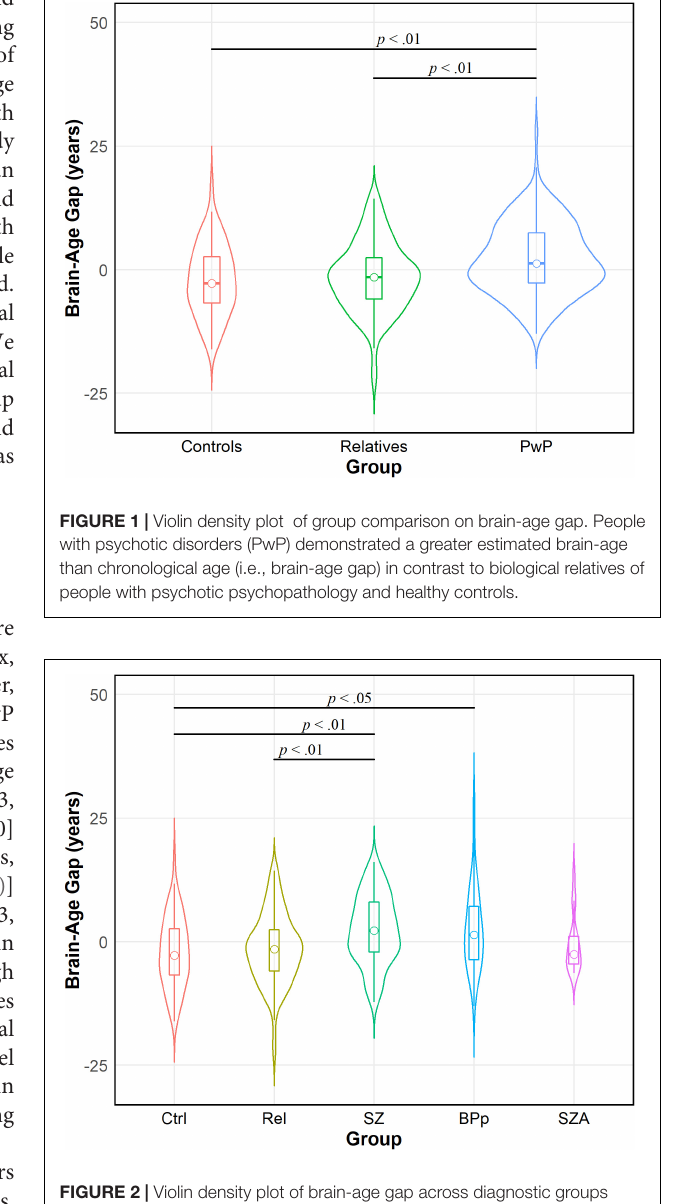
FIGURE 2 | Violin density plot of brain-age gap across diagnostic groups within people with psychotic disorders (PwP). Schizophrenia (SZ) and bipolar I disorder with psychotic features (BPp) groups demonstrated larger brain-age gaps than healthy controls (Ctrl). There were no differences in brain-age gap between the forms of psychotic disorders. Relatives (Rel) had smaller brain-age gaps than SZ; relatives did not differ from BPp, schizoaffective (SZA), or controls. Sample size for SZA is small and interpretation requires